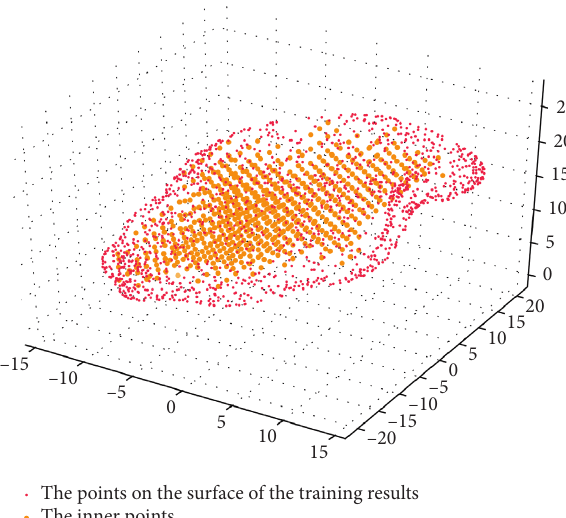
Figure 11: Schematic diagram of hematoma data points.